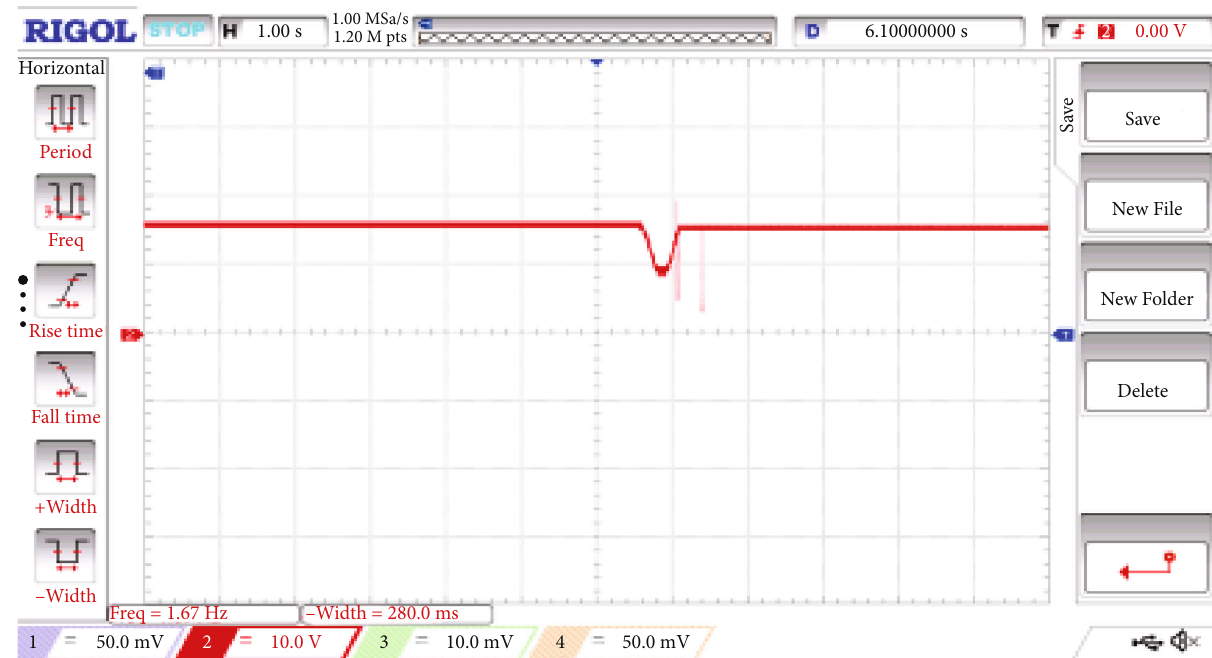
Figure 20: Load current (step fall in